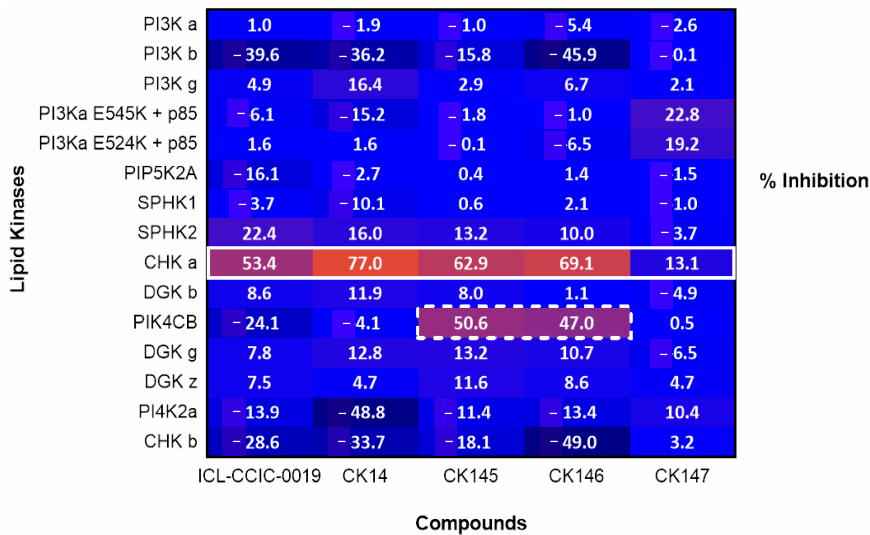
Figure 7. The heatmap of lipid kinase selectivity screening against 15 lipid kinases using ICL-CCIC-0019, CK14, CK145, CK146 and CK147. The inhibition % of CHKA and PIK4CB are boxed in white and dash-line rectangles respectively. The data in percentage represent the mean kinase activity inhibited by drug molecules. Tested concentration of the CHKA inhibitors in the assay: 10 µ M.